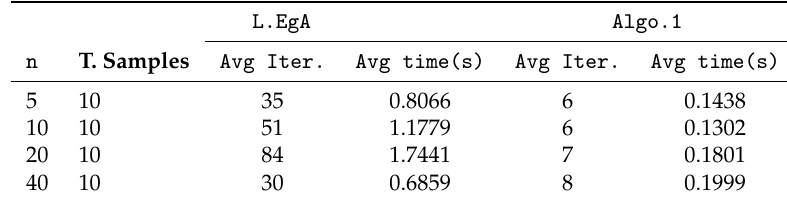
Figure 8. Example 2 for average number of iterations while n = 40. Table 4. Numerical results for Figures 5–8.